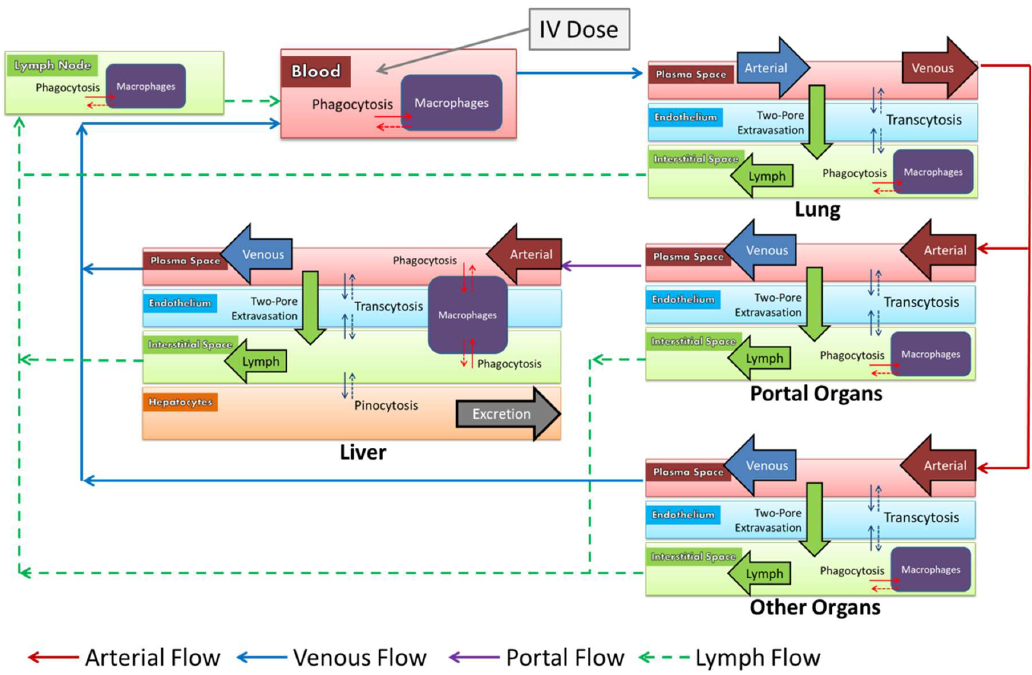
Figure 2. Nanoparticles (NPs) circulate throughout the body, as pictured. They may cross into the interstitial spaces of organs by extravasation or transcytosis across the endothelium. Phagocytic uptake into macrophages and pinocytic uptake into hepatocytes are key determinants of biodistribution. Lymph flow recycles NPs from the interstitial space back into the venous blood. Particles are excreted from hepatocytes into the bile. Renal excretion is negligible for particles >10 nm in diameter.